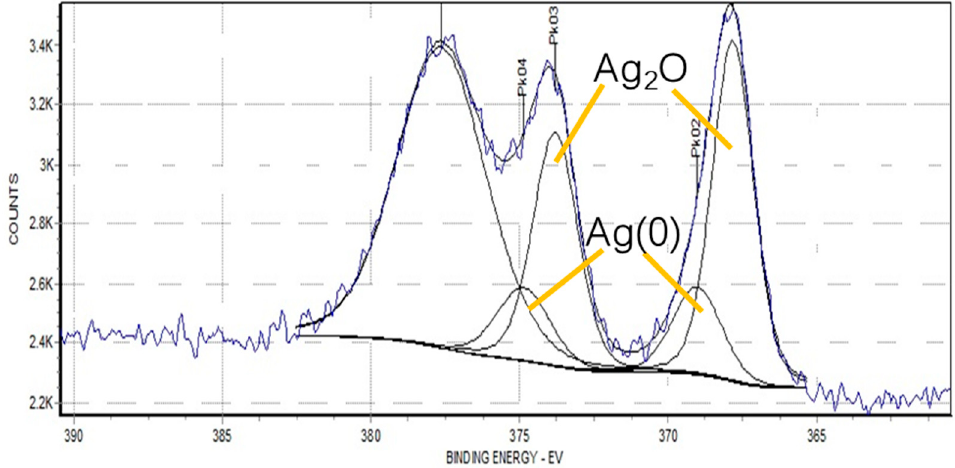
Figure 4. High-resolution XPS spectrum of Ag species in AgNPs–TiO 2 photoactive porcelain-grès tiles.